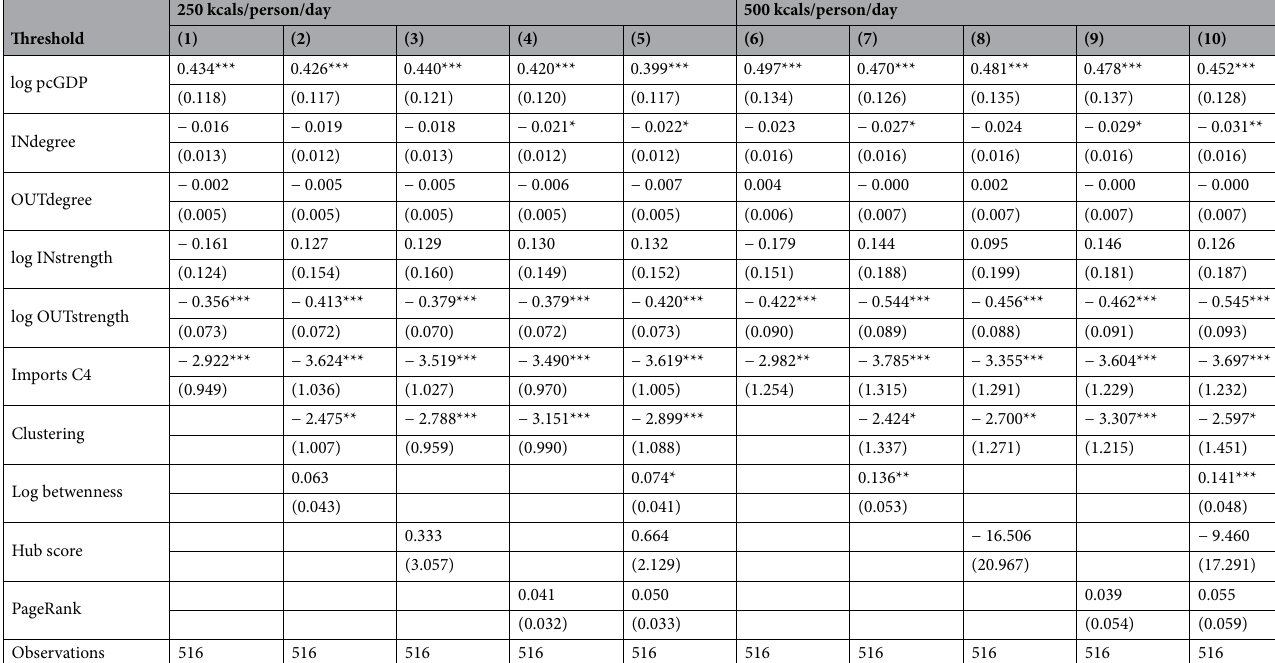
Table 2. Vulnerability analysis: negative binominal regression. The table reports the results on the negative binomial regressions in which the dependent variable is the number of times a country suffers demand deficits higher than 250 and 500 kcals/person/day. Each simulation represents a shock associated to a 30% drop of domestic food production starting from a specific country and diffusing through the network with a given value of the parameter α . We have 172 countries and set α ∈ ( 0, 0.5, 1 ) for a total of 516 simulations. Dummies for α ∈ ( 0, 0.5, 1 ) not shown. Clustering and PageRank measures have been multiplied by 1,000.